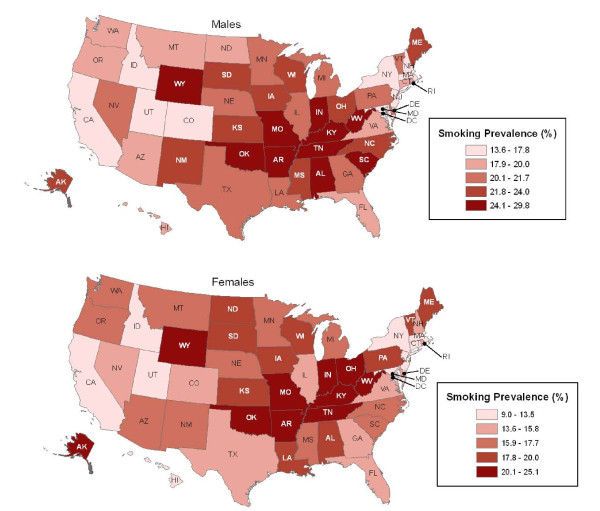
Smoking prevalence by sex and state, 2006-2007. Source: Current Population Survey, 2006/07